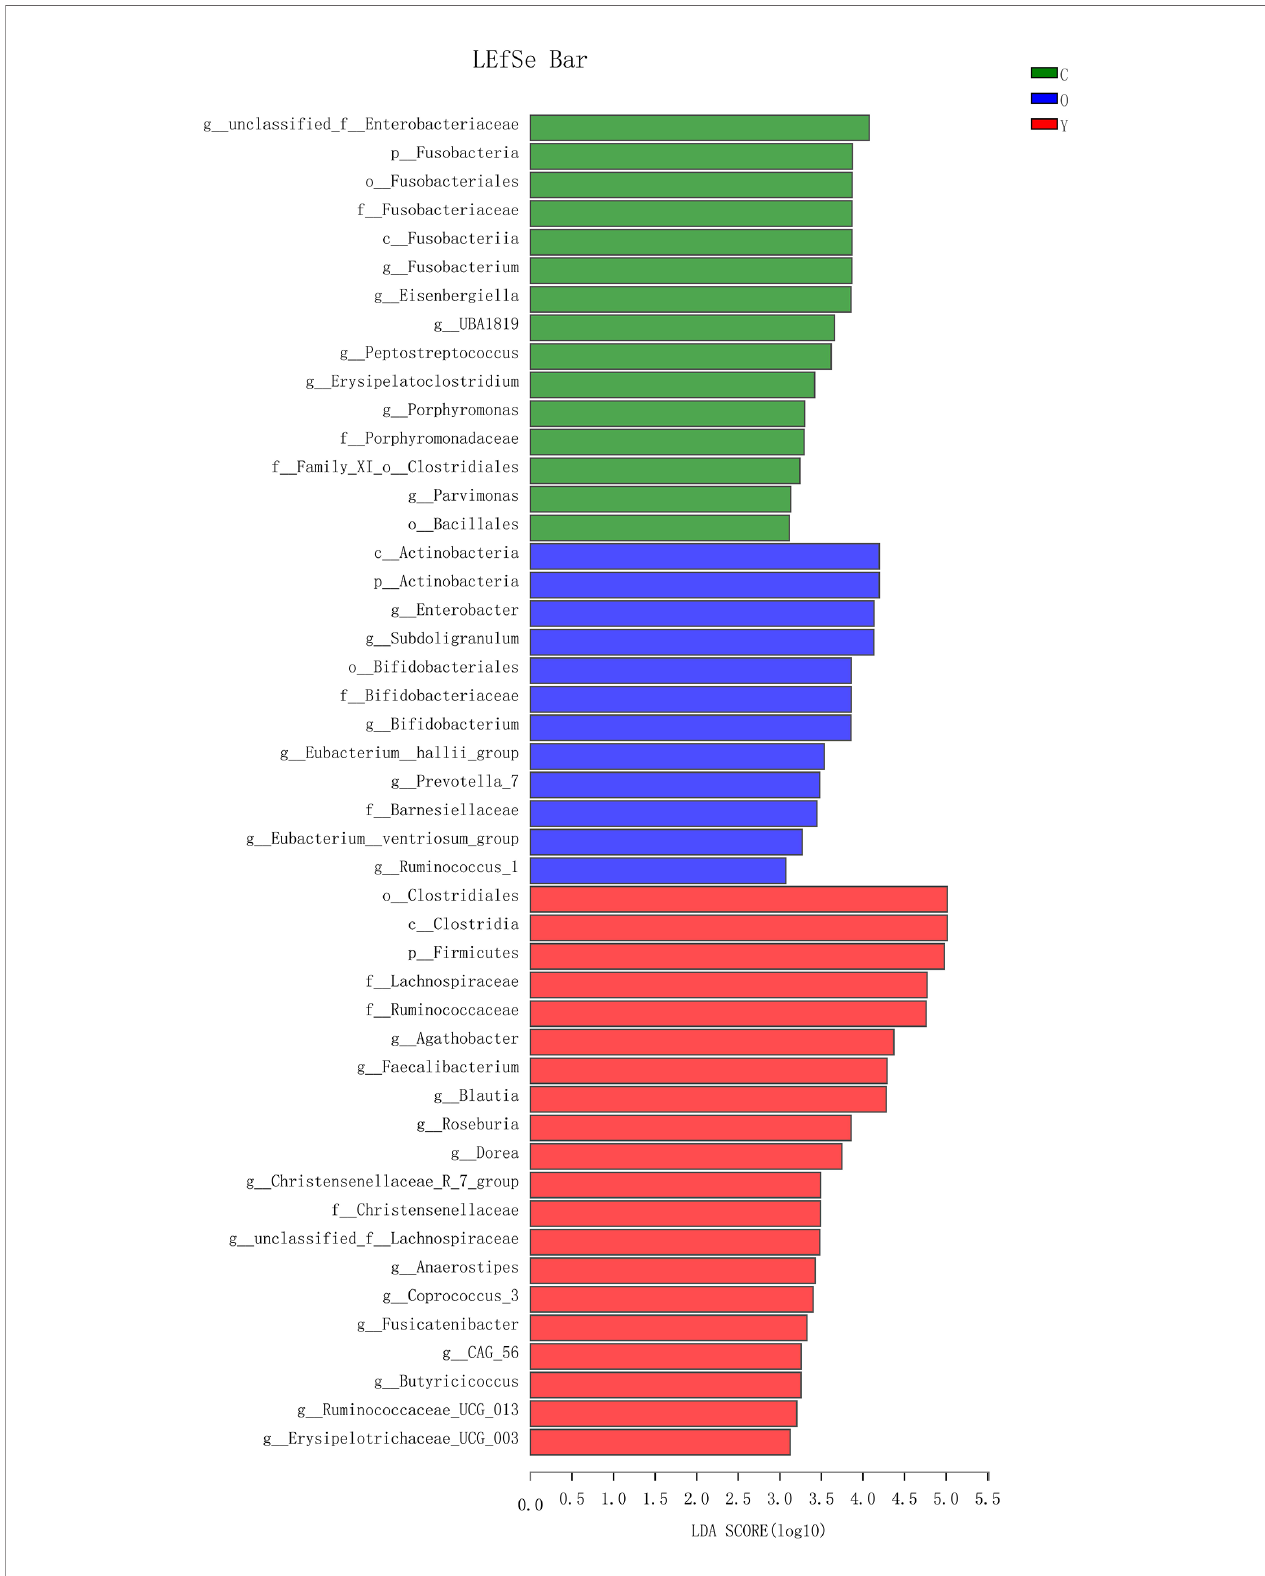
FIGURE 4 | The LDA score obtained by linear regression analysis (LDA), The threshold of linear discriminant analysis score was set as 3, the larger the LDA score is, the greater differences among three groups are. (Y, young volunteers; O, old volunteers; C, CRC patients).